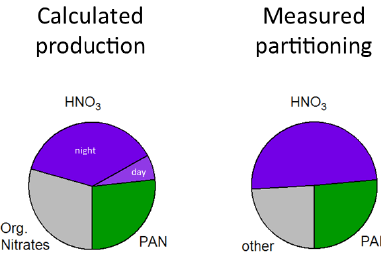
Figure 6. Comparison of the relative importance in 2013 of calcu- lated oxidized reactive nitrogen production rates to the measured NO z partitioning for the three largest components of NO z . On the right chart, “other” refers to the missing NO z which we attribute to the unmeasured organic nitrates.